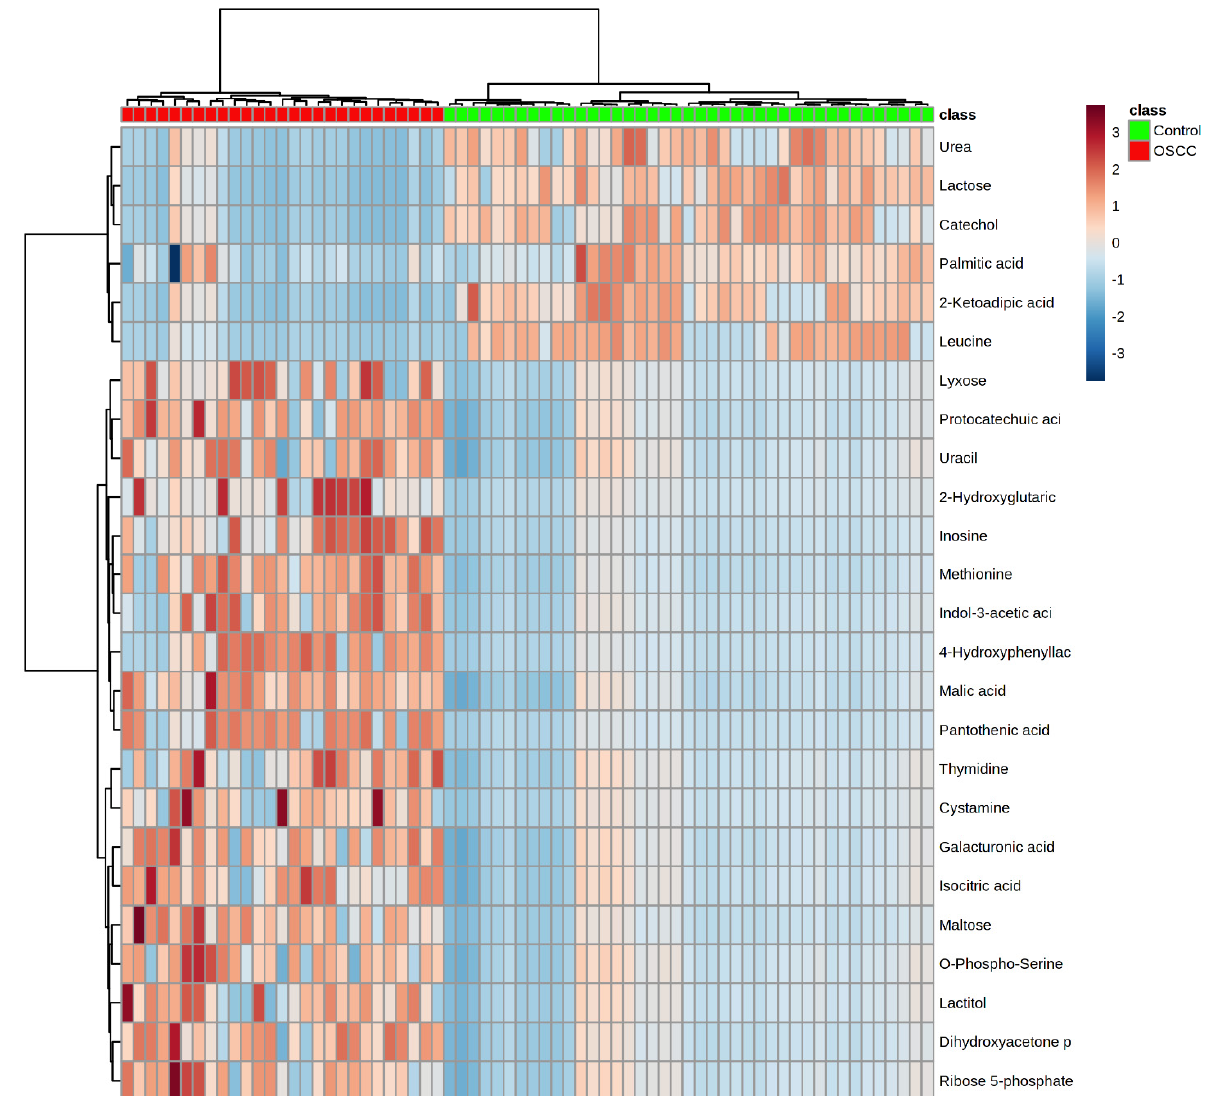
Figure 3. Heatmap using PCA data for OSCC and control classes.